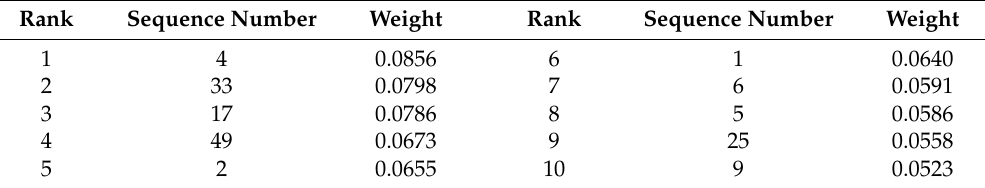
Table 5. Weights of the first 10 features in 1995.